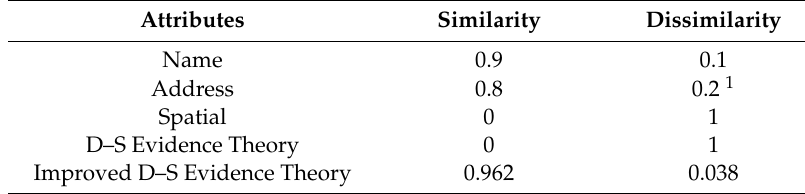
Table 2. Zero trust paradox.